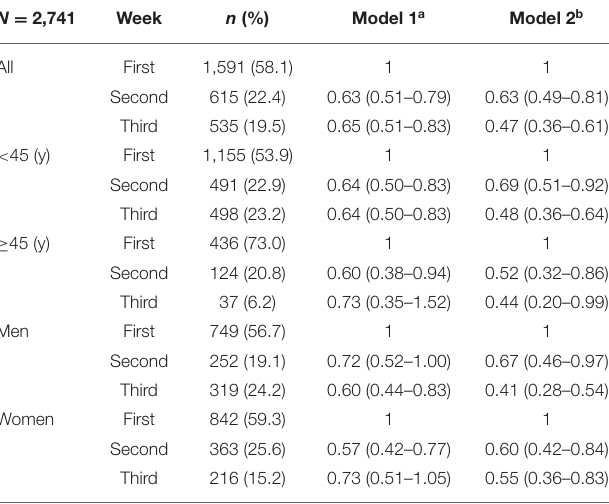
TABLE 5 | Adjusted odds ratios (95% confidence interval) for a higher number of health risk behaviors than before COVID − 19 confinement in the entire study population and age and gender subgroups (reference group: first week of